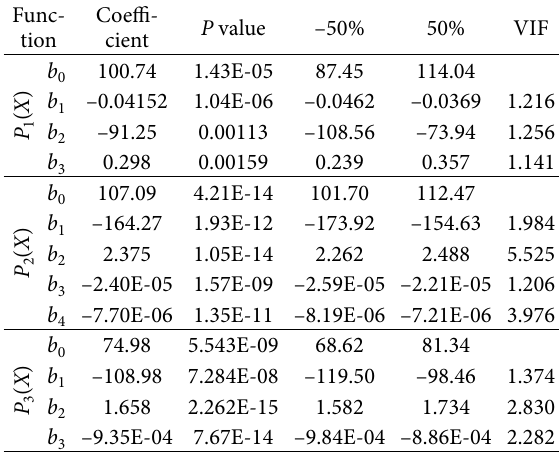
Table 3. The coefficients of regression equations and